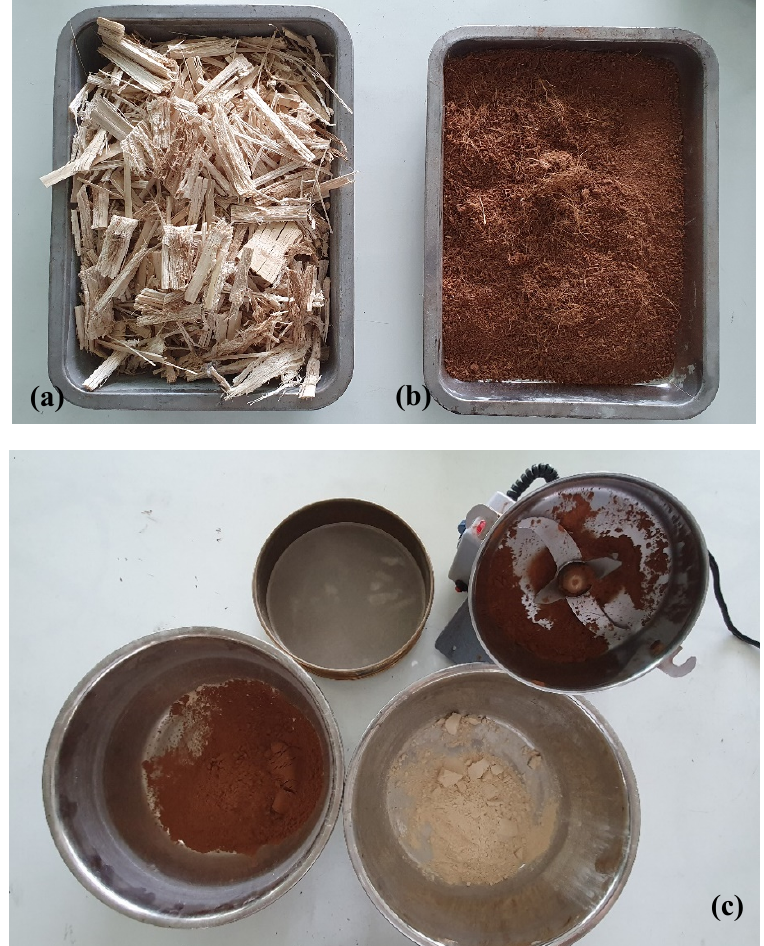
Figure 1. Waste natural materials: ( a ) Bagasse, ( b ) Coconut peat, and ( c ) Bagasse and coconut peat fillers.